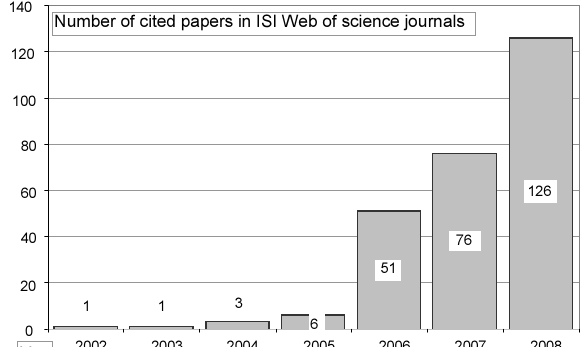
Table 1. “Journal of Civil Engineering and Management”